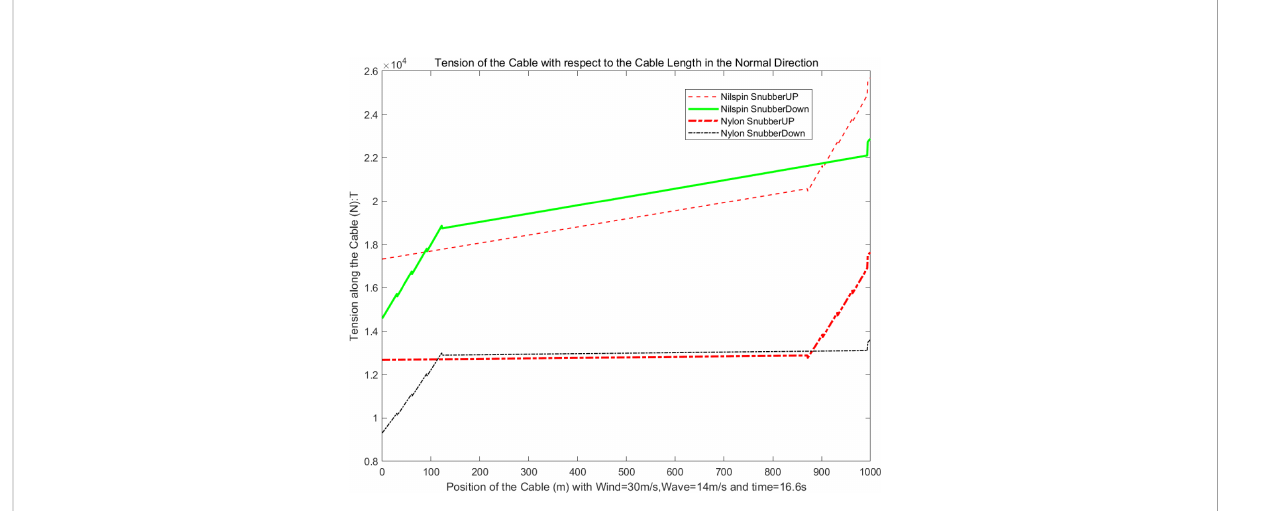
FIGURE 4 Steady-state tension along the cable for a wind speed of 30 m/s, wave speed of 14 m/s, and peak wave period of 16.6 s for different con fi gurations of the mooring line.